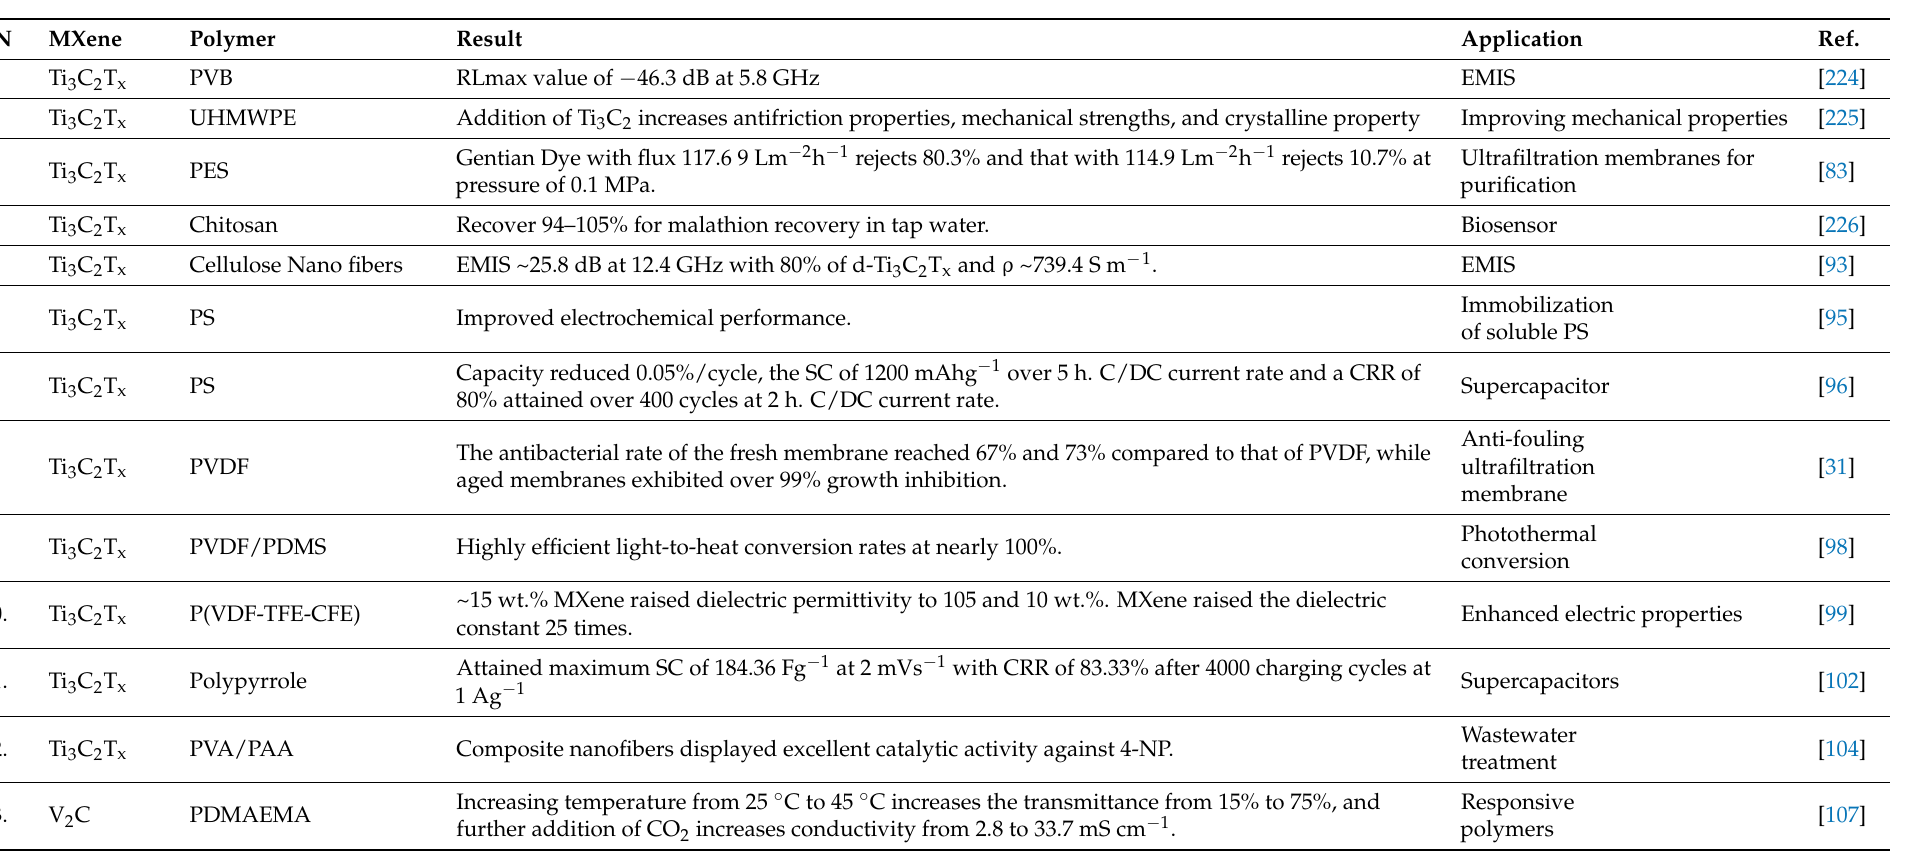
Table 1. Summary of MXene-Polymer Nanocomposites. Adopted with the permission from Ref. [223], European Polymer Journal © 2019 Elsevier Ltd. All rights